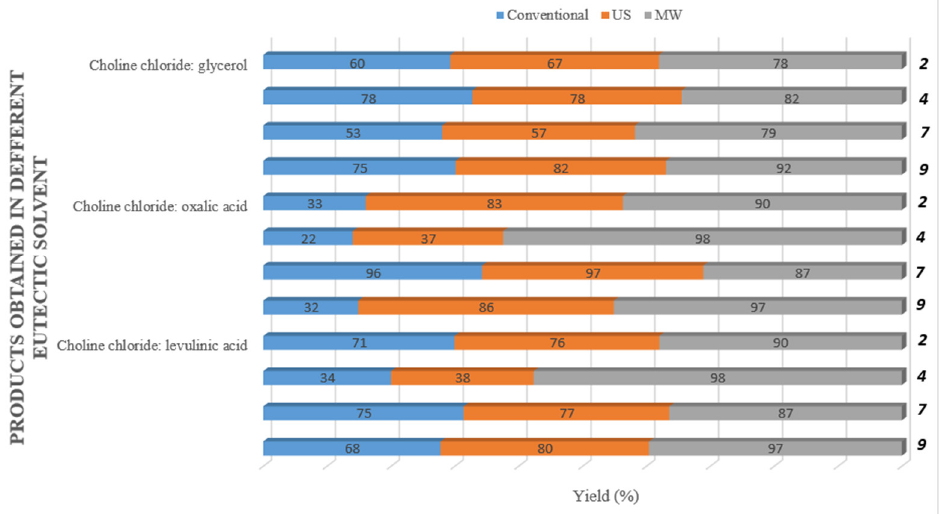
Figure 2. Yields (%) of the compounds 2 , 4 , 7 and 9 obtained by conventional (blue), ultrasonic (orange) and microwave (grey) methods in three eutectic solvents (ChCl/glycerol, ChCl/oxalic acid and ChCl/levulinic acid). The yields depend on the chosen eutectic solvent, but there was a significant increase when microwave irradiation was used.